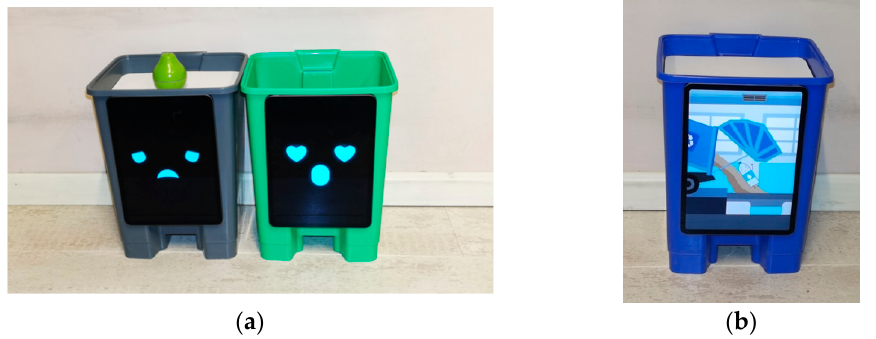
Figure 3. Components of the designed intelligent trash can.